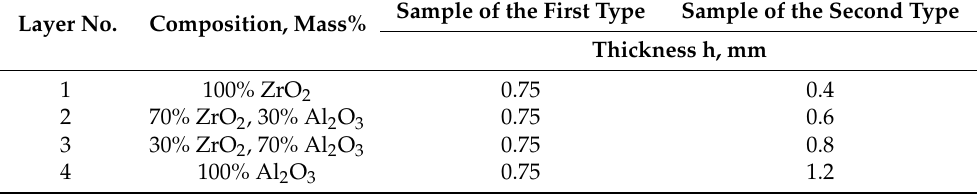
Table 2. Sample elemental composition and thickness.